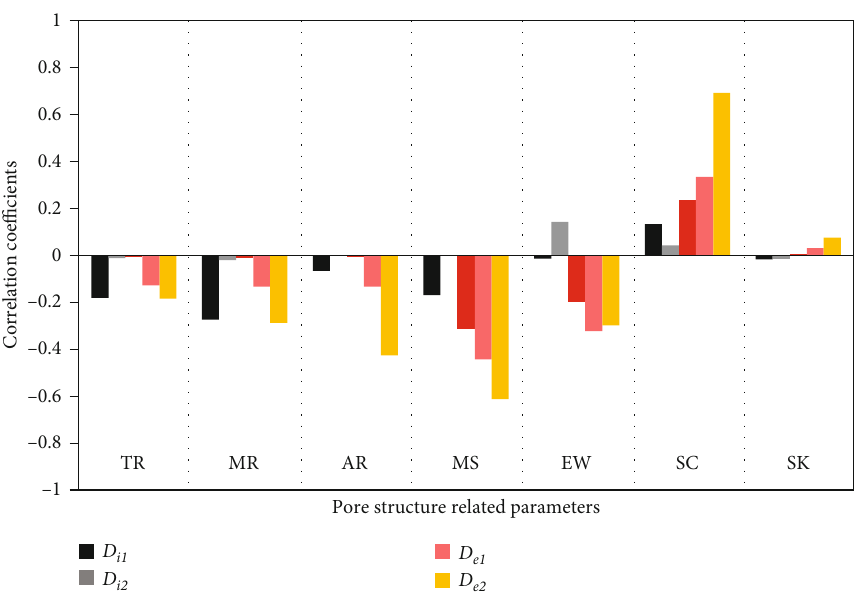
Figure 6: Correlation coe ffi cients of the typical parameters related to pore-throat structures and fractal dimensions. Positive values mean positive relationships, while negative values represent a negative correlation. TR: threshold radius; MR: median radius; AR: average radius; MS: maximum mercury saturation; EW: e ffi ciency of mercury withdrawal; SC: sorting coe ffi cient; SK: